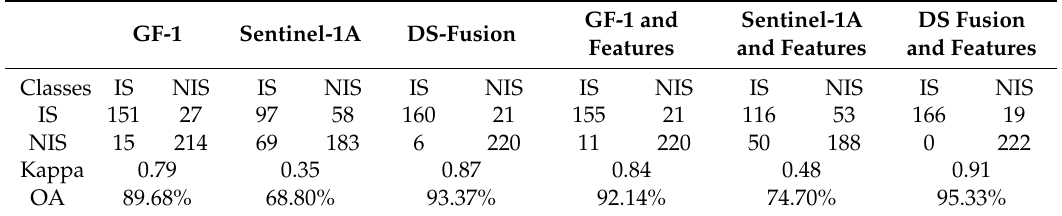
Table 5. The confusion matrix and accuracy assessment of IS and NIS derived from different data sources.